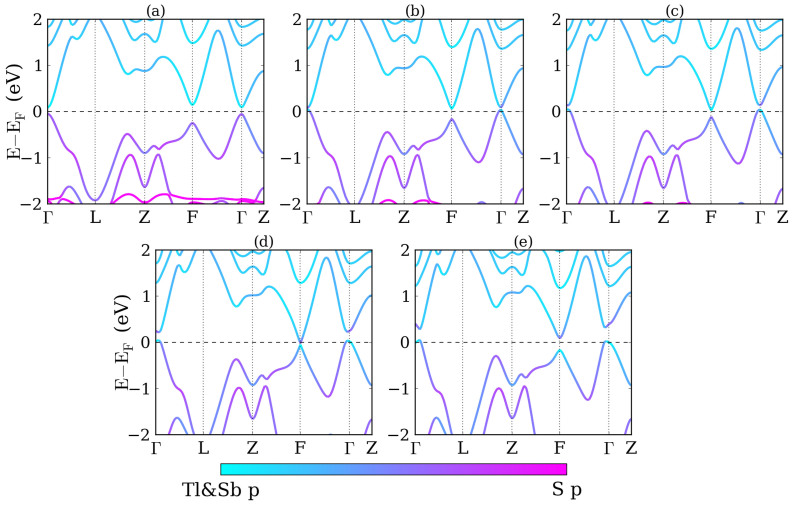
Band structures of TlSbS2 for (a) 0 GPa, (b) 2 GPa, (c) 3 GPa, (d) 5 GPa, and (e) 8 GPa hydrostatic pressures.